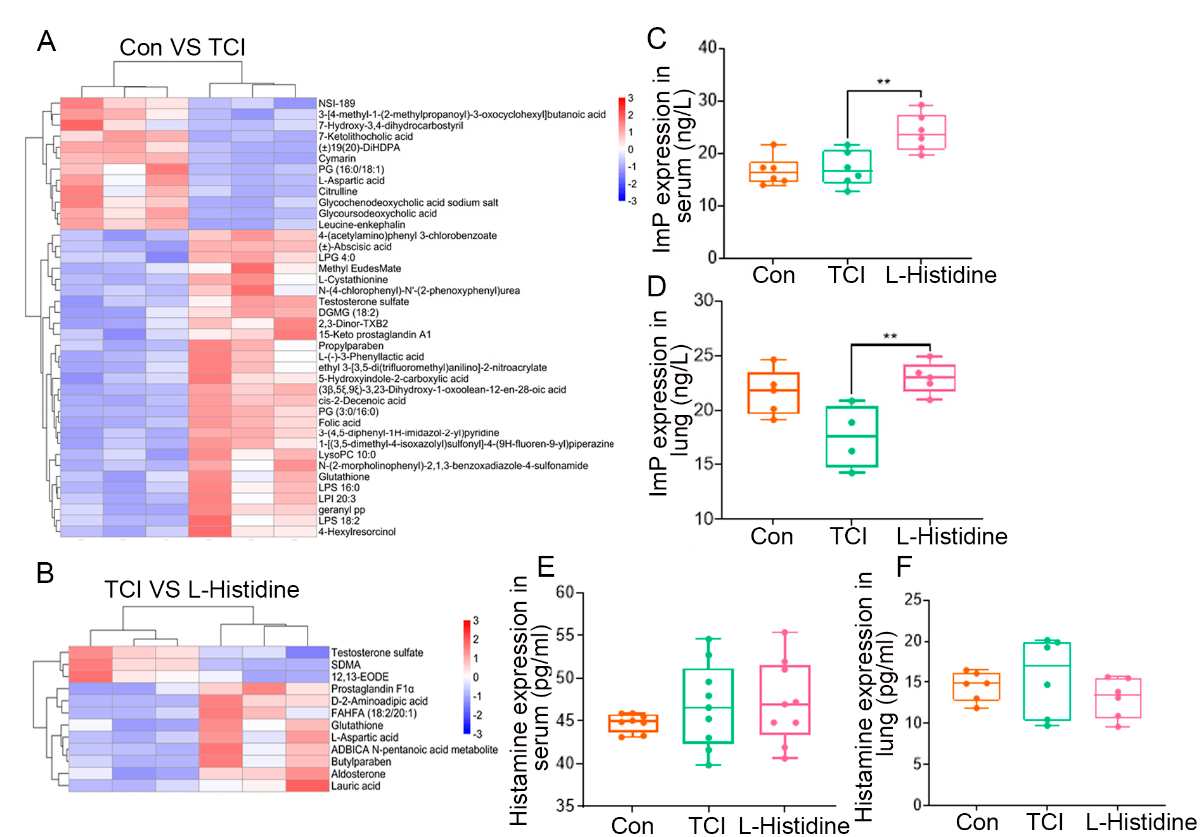
Figure 4. L -Histidine remolds the gut microbiota metabolome fluctuated by local chest irradiation. ( A , B ) Heatmap of the different identified metabolites in the fecal pellets from mice. In the volcano plots, each point represents a metabolite; ( A ) changes in the metabolites in the fecal pellets from mice in the TCI group and the control group; ( B ) changes in the metabolites in the fecal pellets from mice in the TCI group and L -Histidine group. ( C , D ) The ImP expression in serum ( n = 6) and lung ( n = 5) in each group. ( E , F ) The histamine expression in serum ( n = 8) and lung ( n = 6) in each group. (The data are presented as mean ± SD, ** p < 0.01; Student’s t -test.).